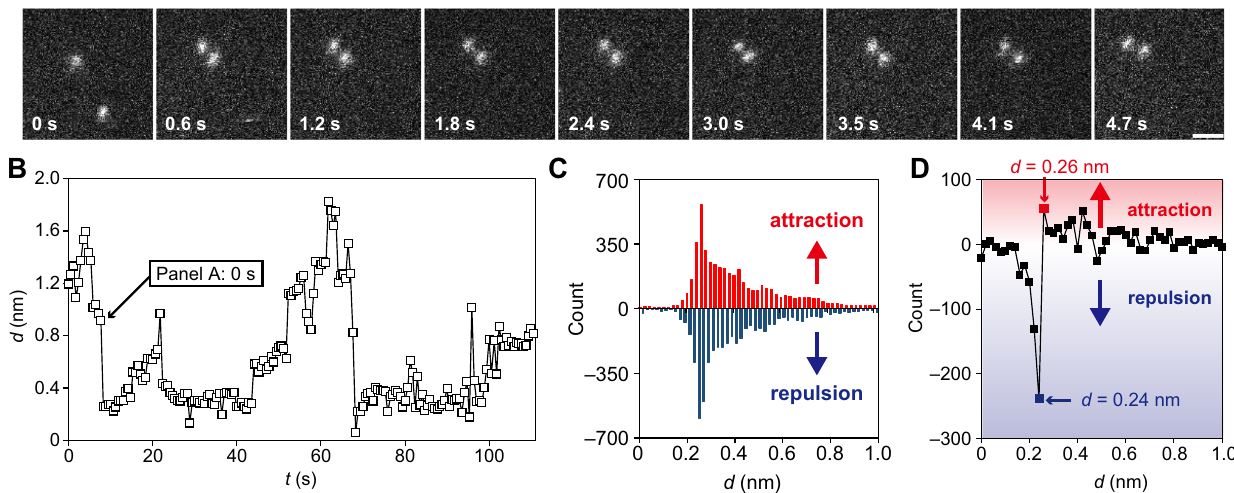
Fig. 3 STEM movie analysis in Au dimers. A Snapshot images of the two gold atoms producing an Au – Au dimer. Scale bar: 0.5 nm. B Temporal change of the interatomic distance d in the Au – Au dimer. The arrow corresponds to the 0-second moment in ( A ). C Evaluation of the direction of the force in the Au – Au dimer. A positive and negative count expresses the repulsion (red) and the attraction (blue), respectively. D The count of the attraction side of ( C ) subtracting the count of the repulsion side of the same fi gure. This fi gure indicates that the attraction and repulsion forces switch at d between 0.24 and 0.26